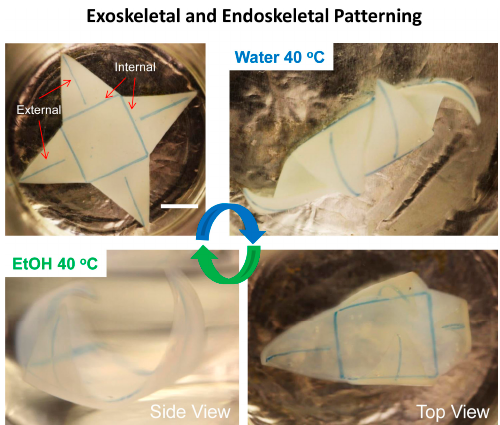
Figure A2. Prototype gel actuator that combines internal and external ionoprints. In water at 40 ˝ C, the actuator resembles a Venus flytrap shape. In EtOH at 40 ˝ C, the actuator resembles a pyramid shape. Scale bar = 1